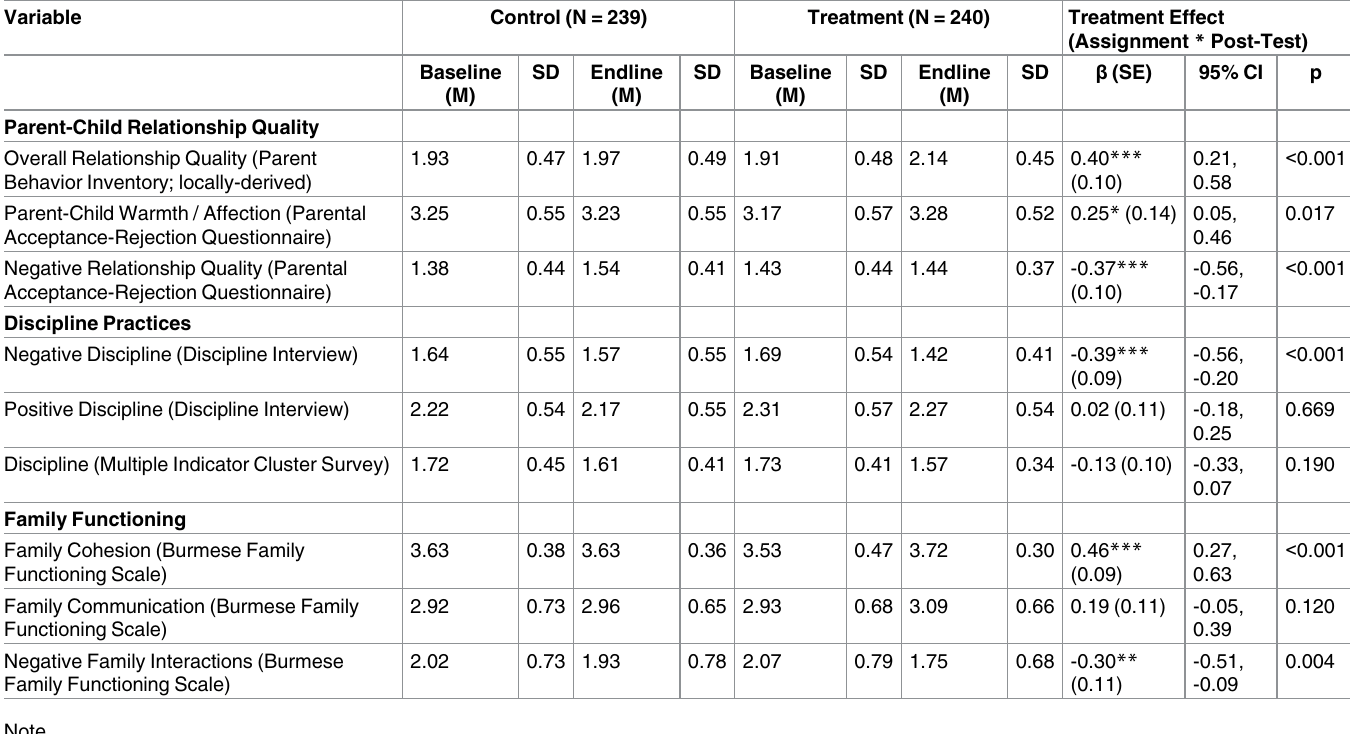
Table 5. Outcomes: Caregiver-Report: Difference-in-differences analysis results (1-month